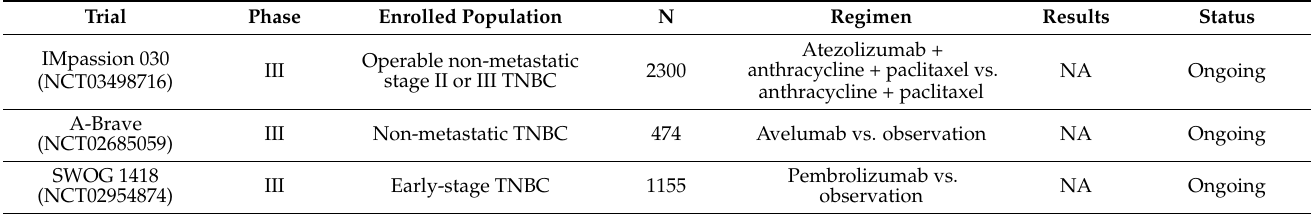
Table 2. PD-1/PD-L1 inhibitors plus adjuvant chemotherapy trials in early-stage